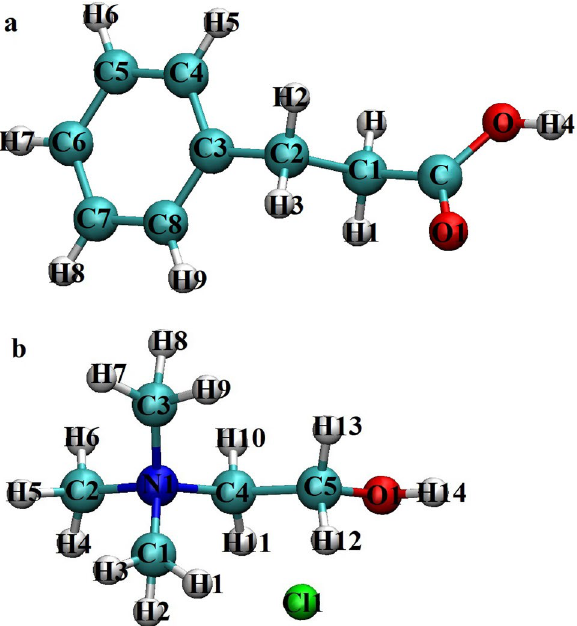
Figure 1. Structures and atom type notations of ( a ) phenyl propionic acid, Phpr, ( b ) choline chloride, ChCl. Atom color code: (Cyan) carbon, (red) oxygen, (blue) nitrogen, (green) chloride ion, (light gray) hydrogen. Atomic label was used in molecular dynamics simulations. The molecular structures were visualized by the VMD package 40